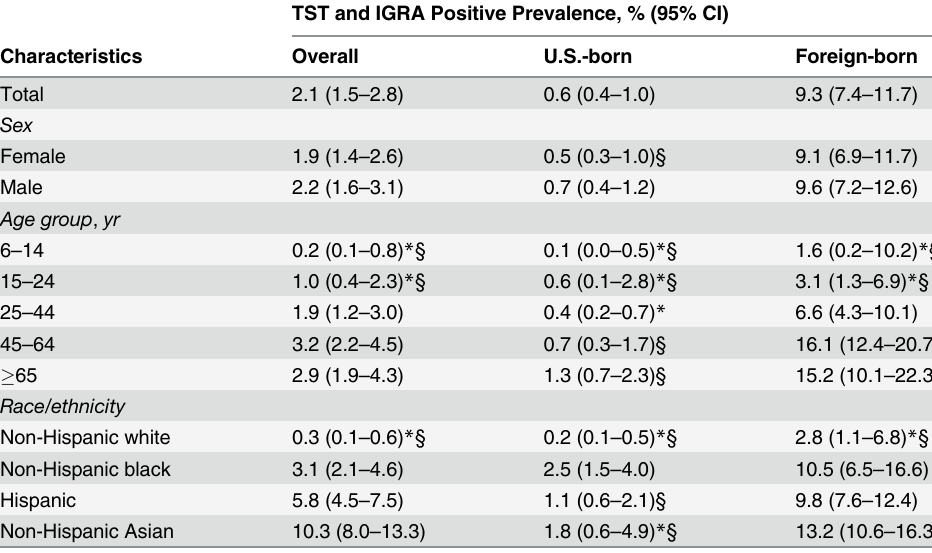
Table 5. Tuberculin Skin Test and Interferon Gamma Release Assay Positive Prevalence in the Civil- ian, Noninstitutionalized U.S. Population, Ages 6+, 2011 – 2012. TST and IGRA Positive Prevalence, % (95% CI)